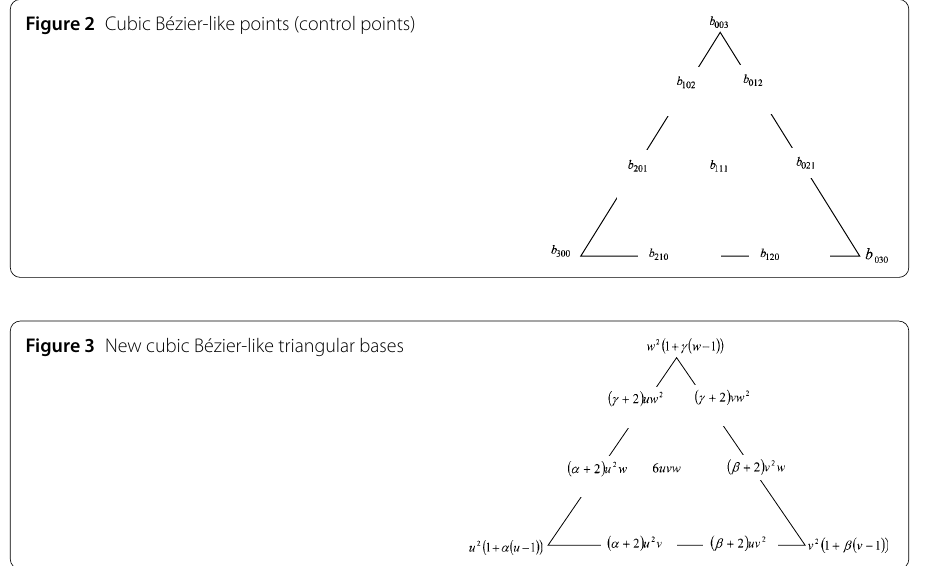
Figure 3 New cubic Bézier-like triangular